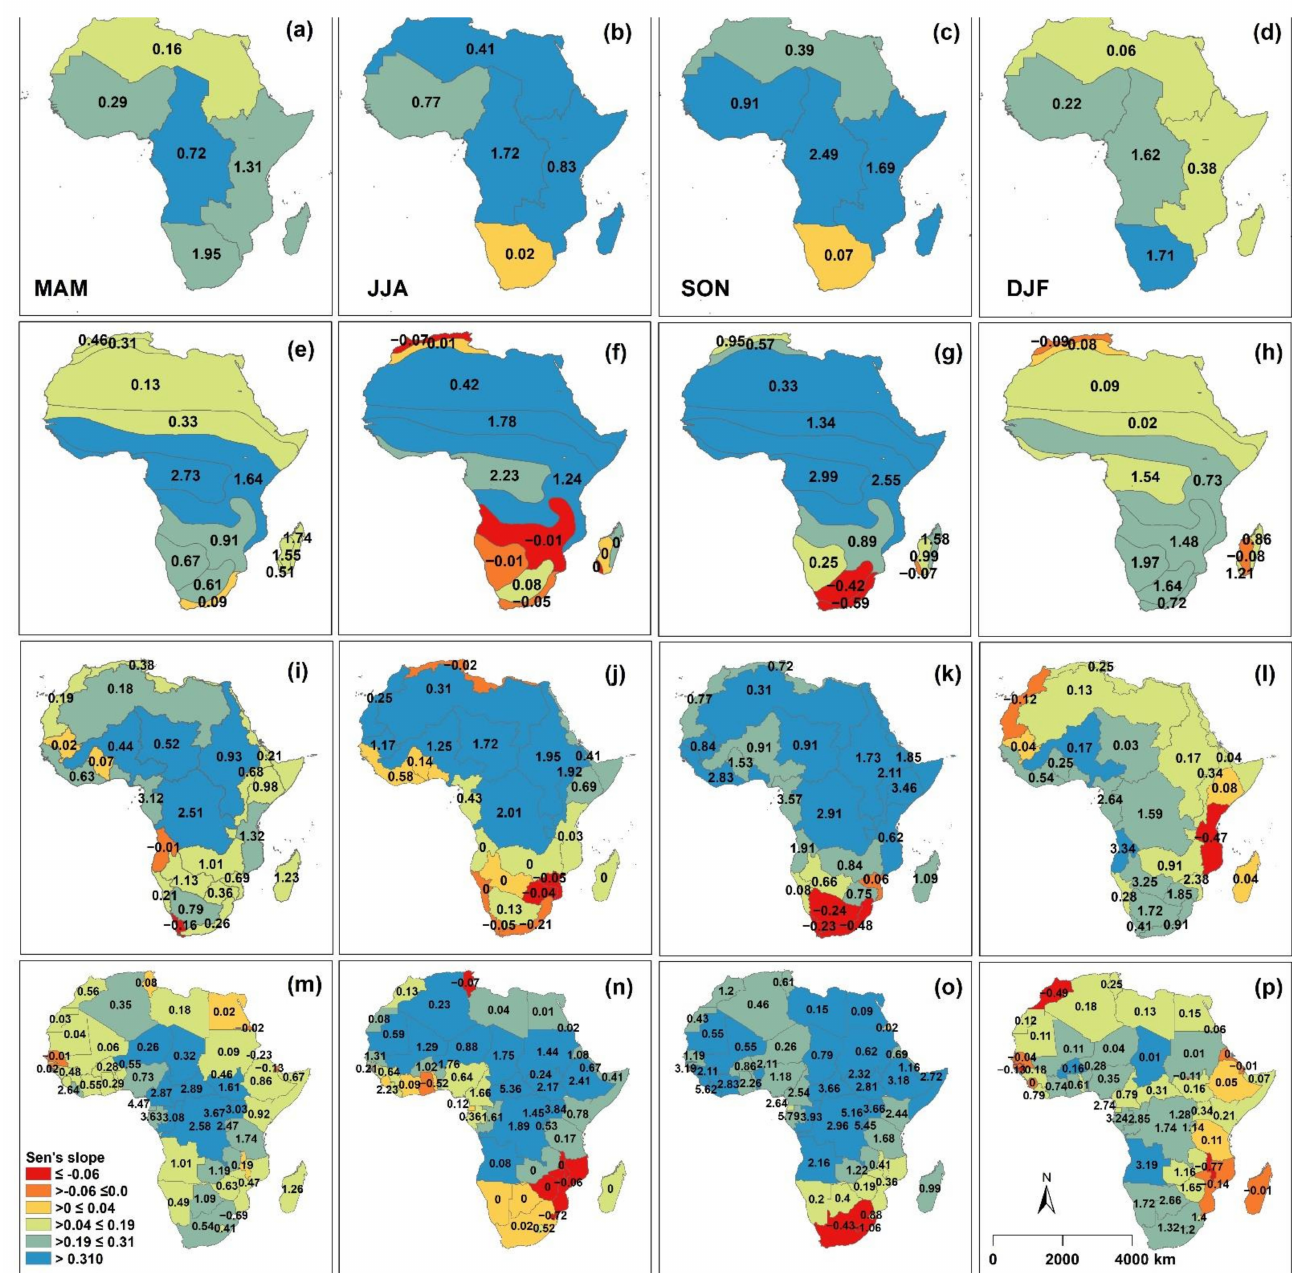
Figure 12. Kendall’s Tau (colour gradient) and Sen’s slope (numbers) as seasonal rainfall (MAM- March-May, JJA—June–August, SON—September–November, DJF—December–February) trends in between 1983 and 2020. ( a ) Regions in MAM, ( b ) regions in JJA, ( c ) regions in SON, ( d ) regions in DJF, ( e ) River basins in MAM, ( f ) River basins in JJA, ( g ) River basins in SON, ( h ) River basins in DJF, ( i ) Climate zones in MAM, ( j ) Climate zones in JJA, ( k ) Climate zones in SON, ( l ) Climate zones in DJF, ( m ) Countries in MAM, ( n ) Countries in JJA, ( o ) Countries in SON, ( p ) Countries in